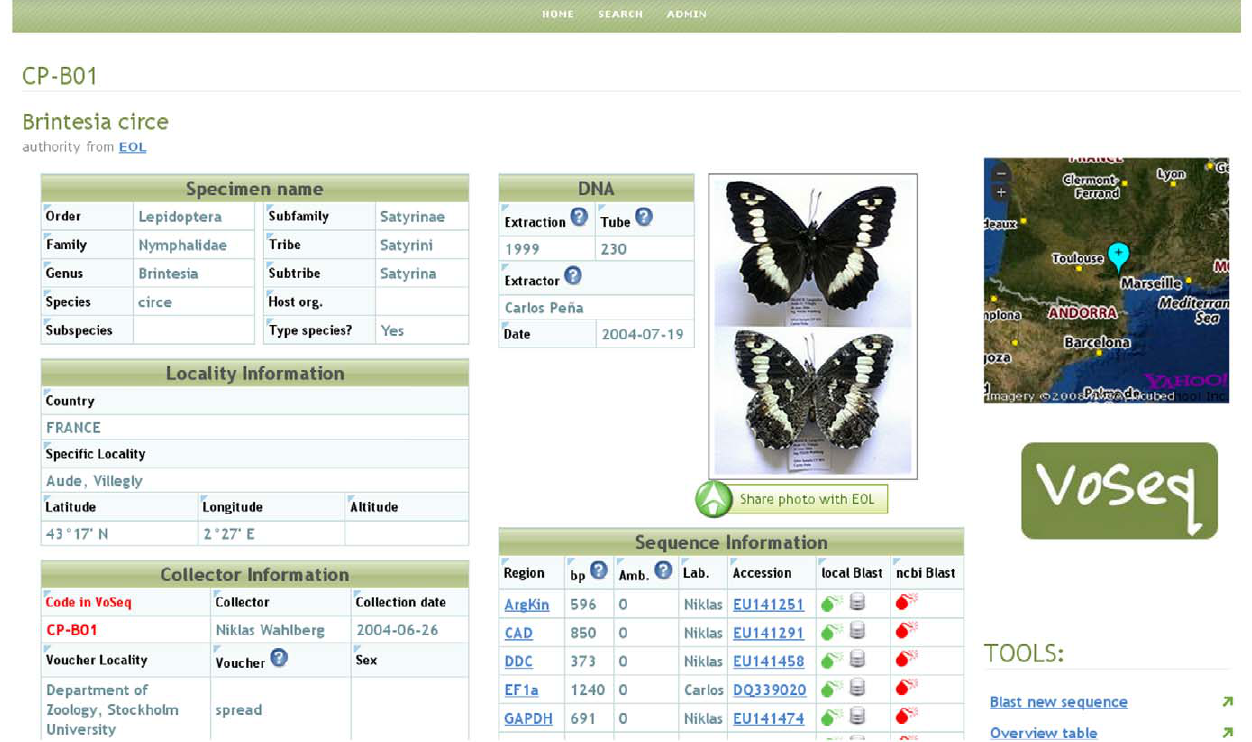
Figure 1. Screenshot of voucher page in VoSeq. It shows specimen and collection data, links to DNA sequences in GenBank, local and remote BLAST tools and mash-ups with Flickr and Yahoo Maps! for voucher picture and geographic location.